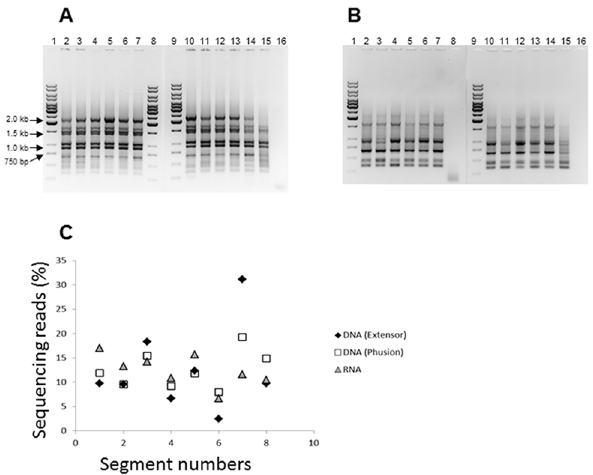
Fig 1. A: Simultaneous RT-PCR amplification of the eight segments of A/California/07/2009 (H1N1) vaccine viruses using Phusion DNA polymerase, 1: 1 kb DNA Ladder, 2: X-181-M1, 3: X-179A-M1, 4: X- 181-M2, 5: X-179A-M2, 6: X-181-M3, 7: X-179A-M4, 8: 1 kb DNA Ladder, 9: 1 kb DNA Ladder, 10: 121XP-M4, 11: X-181-M4, 12: X-179A-M3, 13: X-179A-M5, 14: X-179A, 15: X-181, 16: Negative control (H 2 O). B: Simultaneous RT-PCR amplification of the eight segments of A/California/07/2009 (H1N1) vaccine viruses using Thermo Scientist Extensor Mix, 1: 1 kb DNA Ladder, 2: X-181-M1, 3: X-179A-M1, 4: X-181-M2, 5: X-179A-M2, 6: X-181-M3, 7: X-179A-M4, 8: Negative control (H 2 O), 9: 1 kb DNA Ladder, 10: 121XP-M4, 11: X-181-M4, 12: X-179A-M3, 13: X-179A-M5, 14: X-179A, 15: X-181, 16: